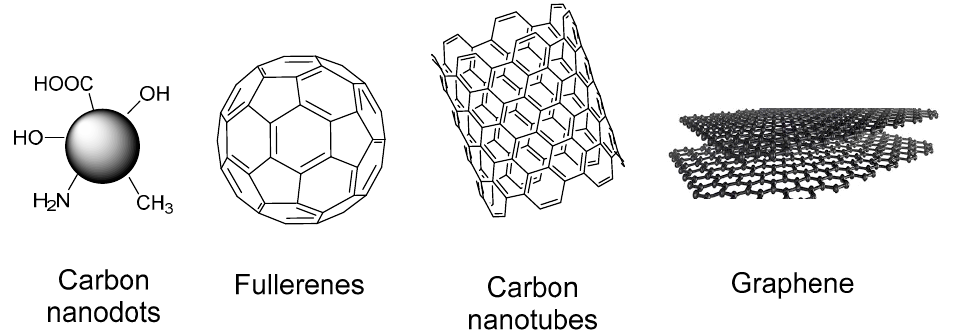
Figure 8. General structures of some carbon nanomaterials.